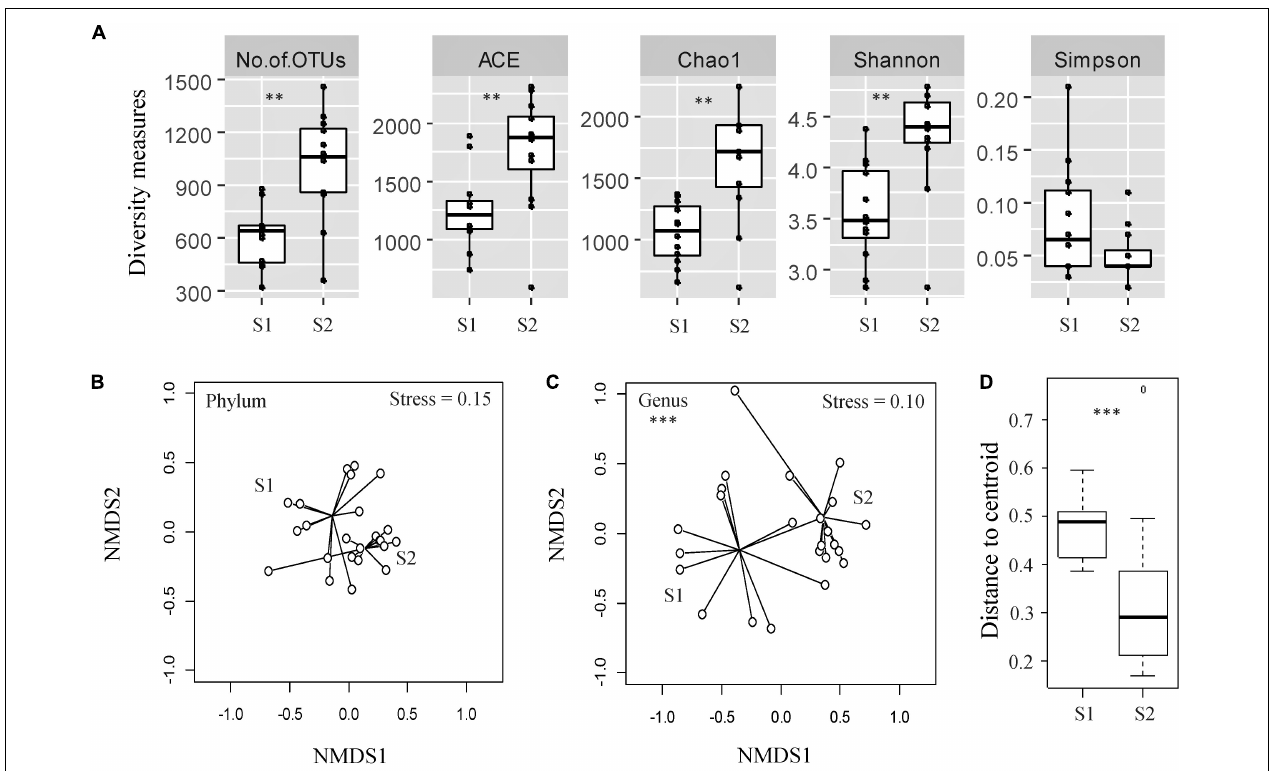
FIGURE 1 | Assessment of alpha- and beta-diversity of fecal samples taken from the same cohort of veal calves at early (Sampling 1/S1, n = 12) and late (Sampling 2/S2, n = 12) stages of production. (A) Alpha-diversity measures of individual samples from calves from same cohort at S1, S2. (B,C) Non-metric multidimensional scaling (NMDS) plots based on Bray-Curtis distance matrix encompassing 24 datasets from the two stages of veal production. (D) Distance to centroid from the multivariate homogeneity of groups dispersions test. Triple asterisks ( ∗∗∗ ) represent statistical significance with p < 0.001, double asterisks ( ∗∗ ) represent p < 0.01, a single asterisk ( ∗ ) represents p < 0.05, and no asterisk represents no observed statistical significance.